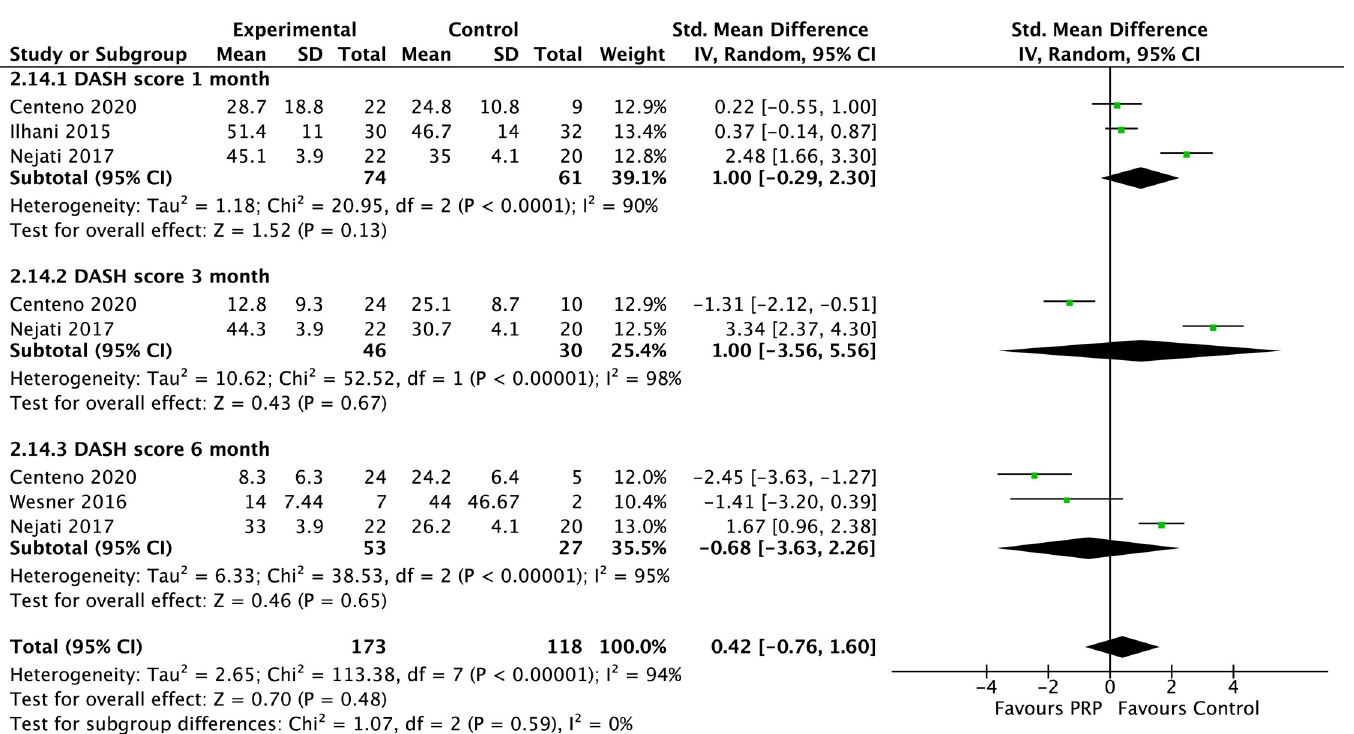
PLOS ONE | https://doi.org/10.1371/journal.pone.0251111 May 10,